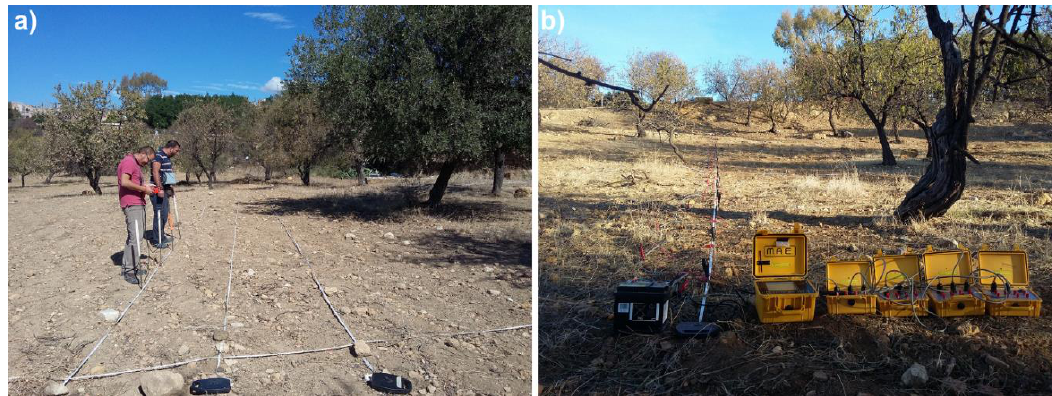
Figure 2. Data acquisition using the Elmes ADD-01 Resistivity meter ( a ) and the M.A.E. A3000E Resistivity meter ( b ).